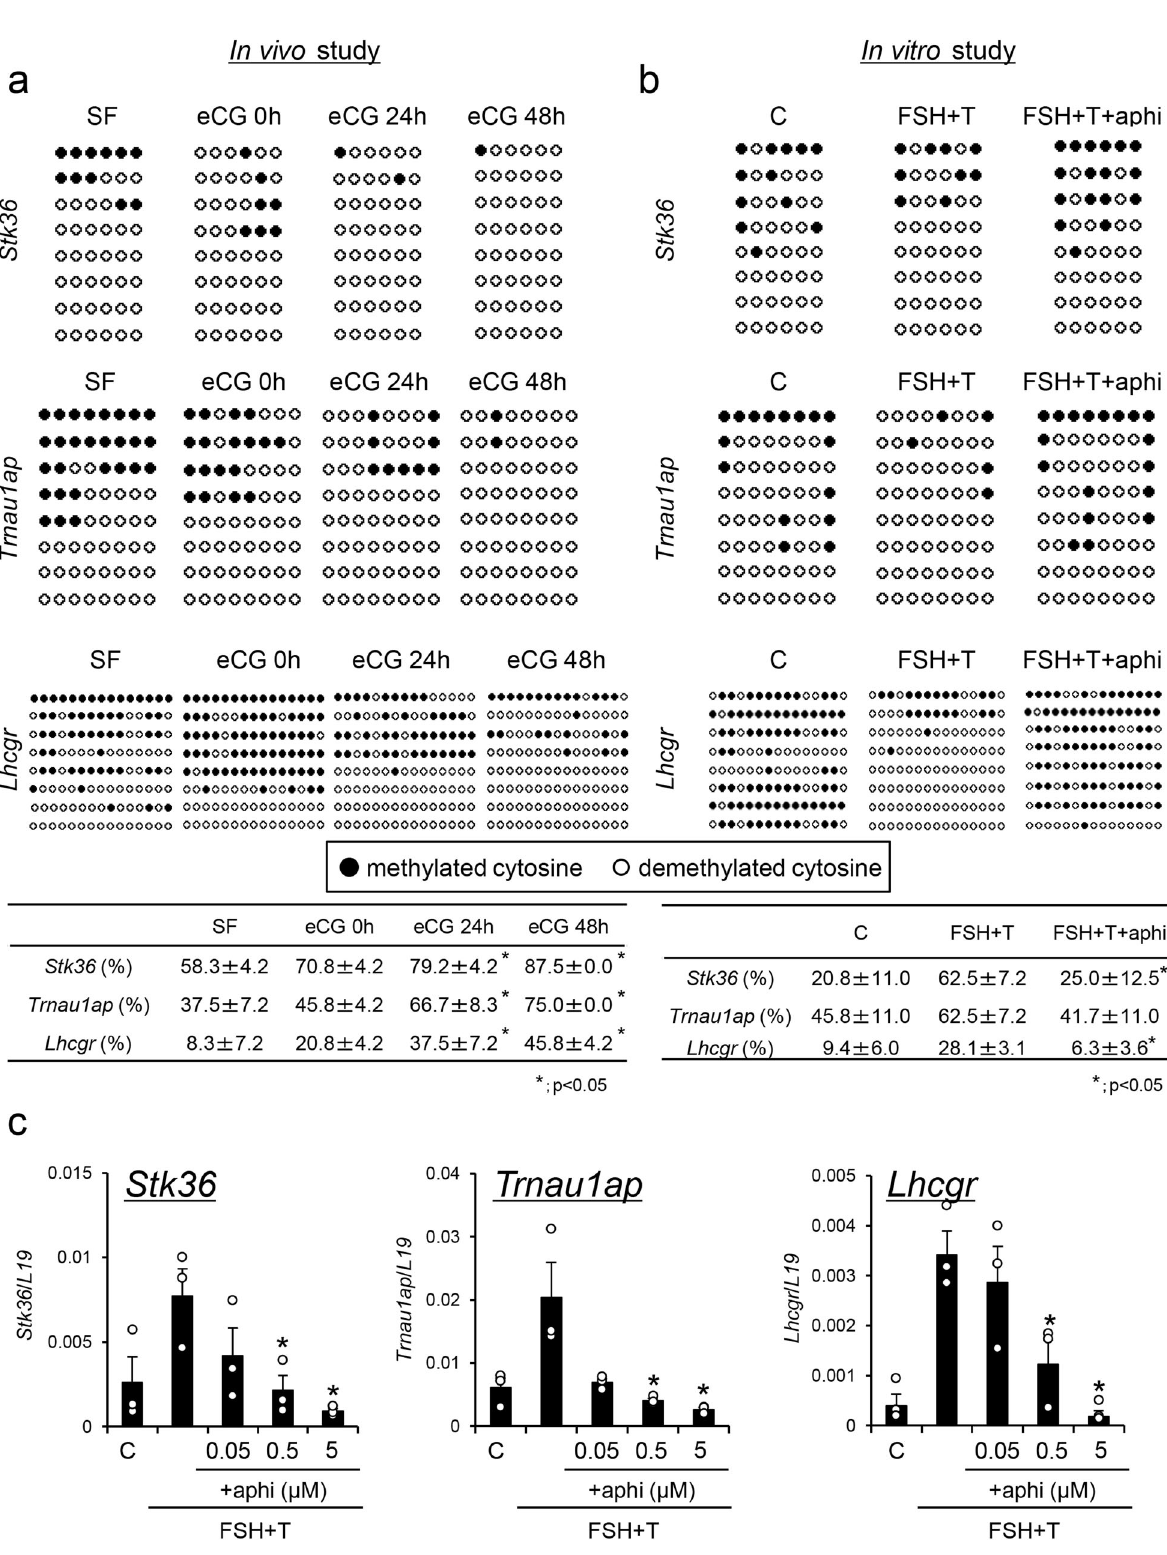
preovulatory stage are dependent on speci fi c temporal changes in DNA methylation and histone acetylation (Fig. 8). In proliferating cells, DNA replication points are formed at G1 phase, in which genomic AT-rich regions are open 35 . At S-phase, proteins involved in DNA replication, such as DNA helicase and PCNA, are recruited to these regions 36 . DNMT1 is also observed